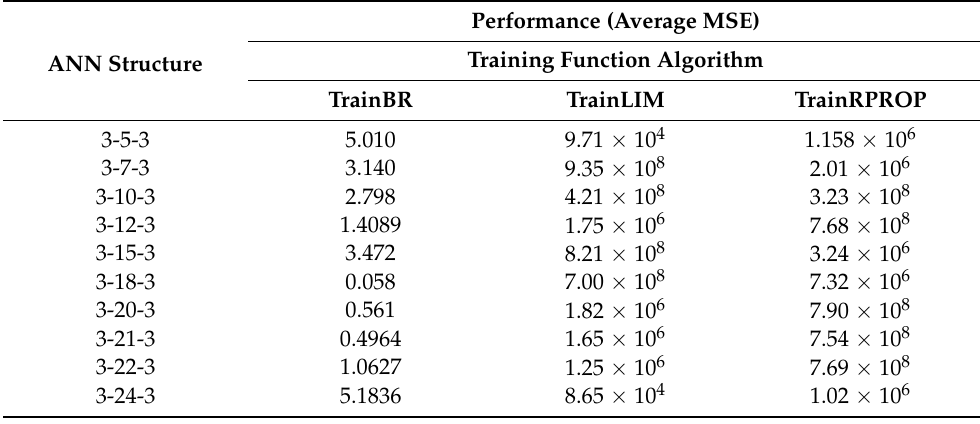
Table 3. The comparison of different ANN structures’ performance with one, two, and three hidden layers by changing the number of neurons in the hidden